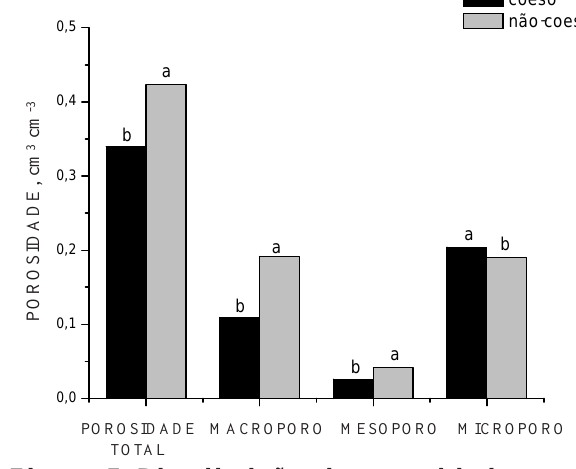
Figura 5. Distribuição da porosidade total, macroporos, mesoporos e microporos nos horizontes: coeso e não-coeso. Médias seguidas da mesma letra, nas colunas, não diferem entre si a 5 % pelo teste de Tukey.